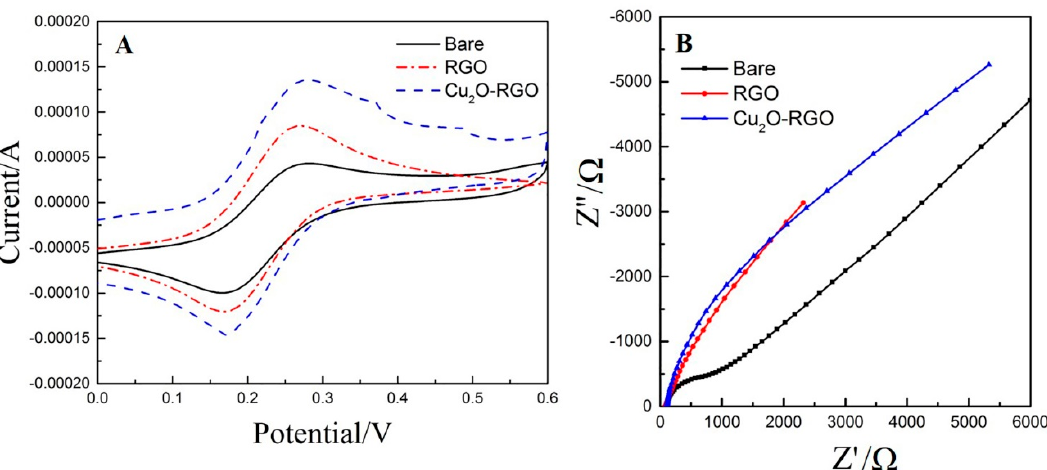
Figure 2. Cyclic voltammograms ( A ) and Nyquist plots ( B ) of bare GCE, RGO, or Cu 2 O-RGO-modified GCEs in 5 × 10 − 3 mol/L [Fe(CN) 6 ] 3 − /4 − solution. The CVs was recorded in 0.1 M PBS (pH = 3.5) at the scan rate of 100 mV/s. The Nyquist plots was measured with alternating current (AC) amplitude of 5 mV, from 1 × 10 5 Hz to 0.1 Hz at their open circuit voltage.